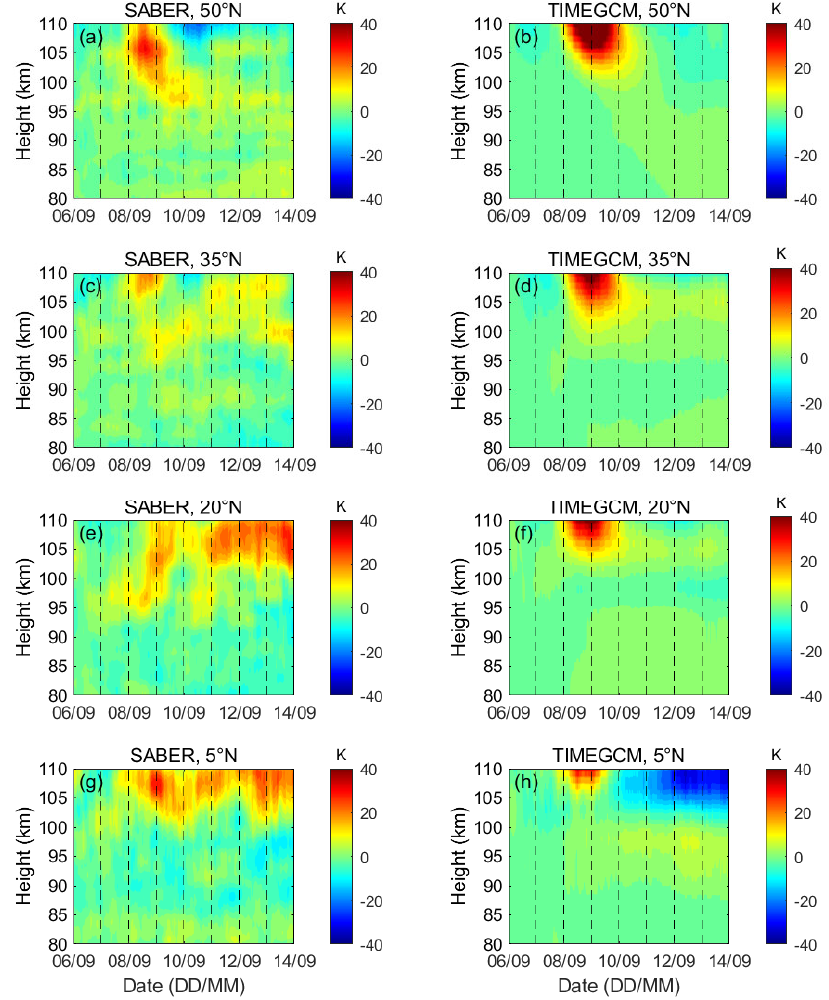
Figure 3. Similar to Figure 2, but for a latitude range of 50° N–5° N. In TIMEGCM simulations at 50° N (Figure 3b), the temperature increased with a peak of ~60 K and propagated down to ~102 km; the storm effects lasted for ~two days. The peak of model temperature changes at 35° N (Figure 3d) was larger than 50 K above ~103 km, and the storm influences lasted for ~two days. Conversely, at 20° N (Figure 3f), the enhancement of TIMEGCM temperature was downward to ~104 km and continued only ~two days, with a temperature response peak of ~40 K. Furthermore at 5° N, there was a temperature increase in TIMEGCM about ~two days above 106 km. Another essential fea ‐ ture at 5° N (Figure 3h) is that the temperature increase was followed by a temperature decrease with a peak of 30 K and lasted for ~four days. The temperature variations in both observations and simulations during the storm appeared with the commence of the storm’s first main phase at the low and middle lati ‐ tudes in the northern hemisphere in the MLT region. These variations were mainly man ‐ ifested in the increase of temperature with peak values greater than ~20 K. The tempera ‐ ture responses were changing with altitude, especially larger temperature variations at higher altitudes. During this storm, there was little response at temperatures below ~95 km.